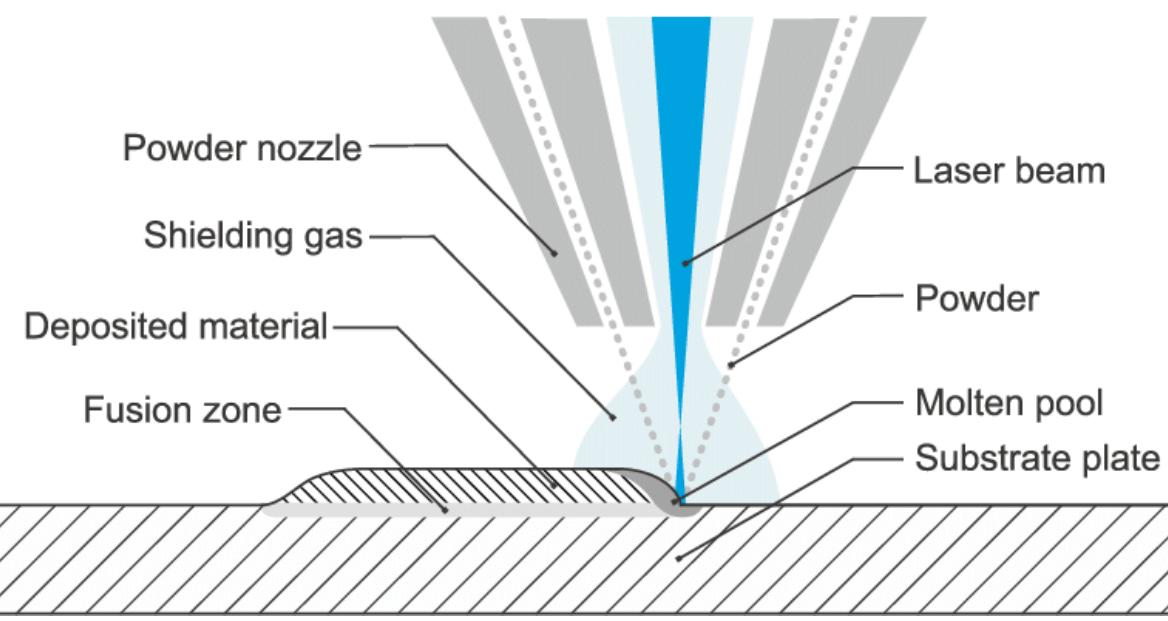
Figure 8. Schematic illustration of the DED process [105].